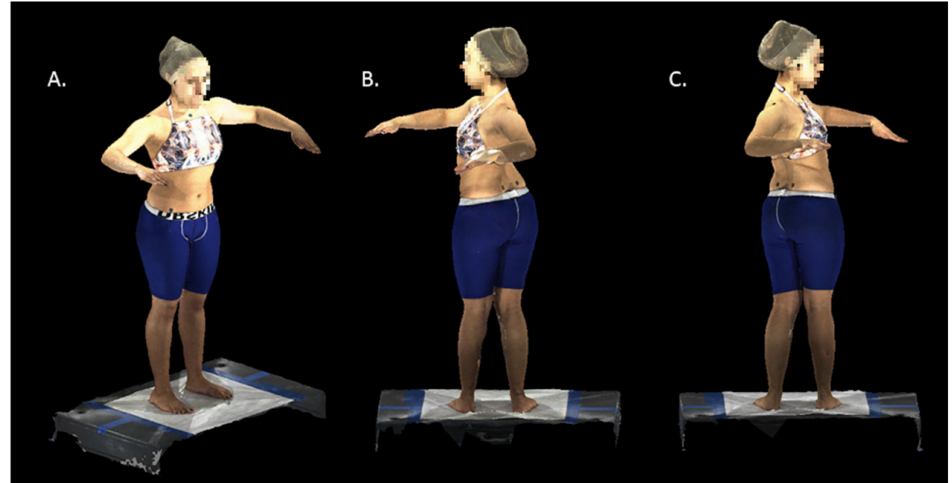
Figure 1. 3D Topographic scans: ( A ) forward starting position; ( B ) maximum left twist; ( C ) maximum right twist.